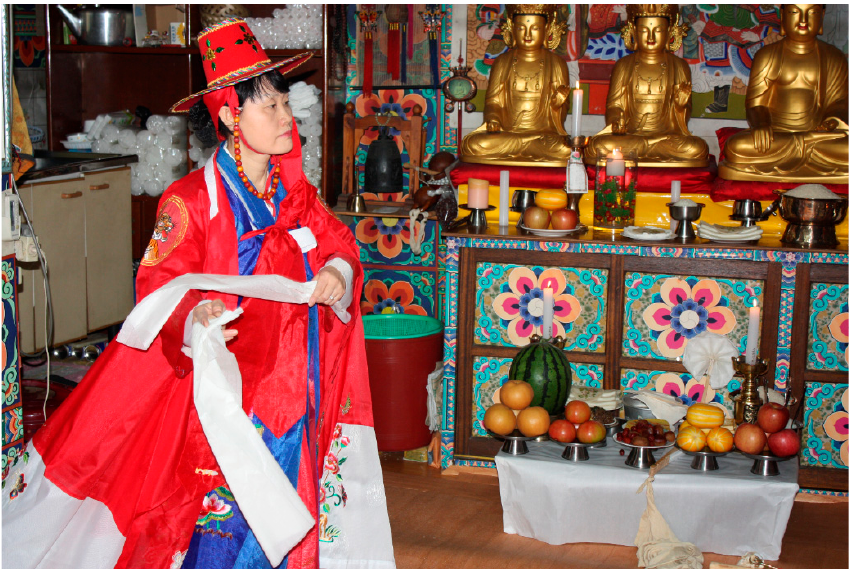
Figure 5. A Mansin manifesting a Mountain God in a shrine displaying offerings for a kut . God pictures are on the rear wall; the Buddha image would not have been seen on early 20th-century mansin altars, piles of candles (left) are from clients. Photograph by Homer Williams.